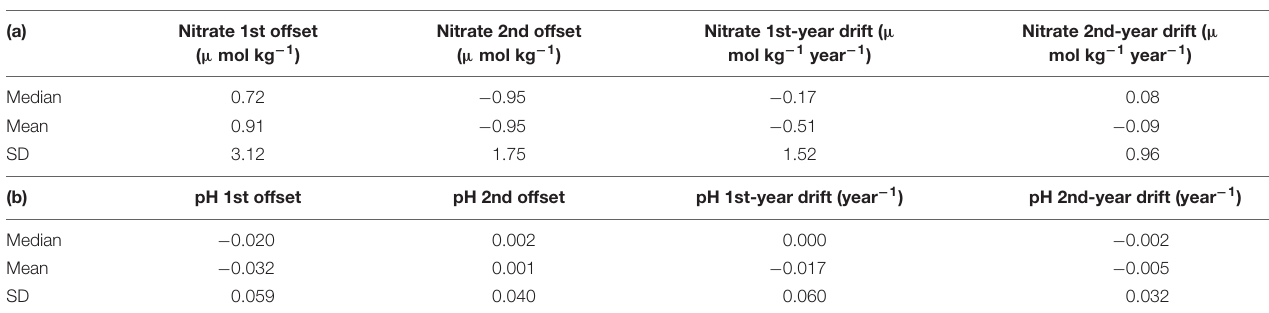
FIGURE 10 | Histograms of first and second offsets (top), and first-year and second-year drift rates (bottom) for nitrate (A) and pH (B) data. Offsets were computed as float data minus reference data at a nominal calibration depth of 1500 m; the second offset is relative to the first. Drift rates were computed using a Model I regression on the anomaly time series. TABLE 1 | Data adjustment summary statistics for nitrate (a) and pH